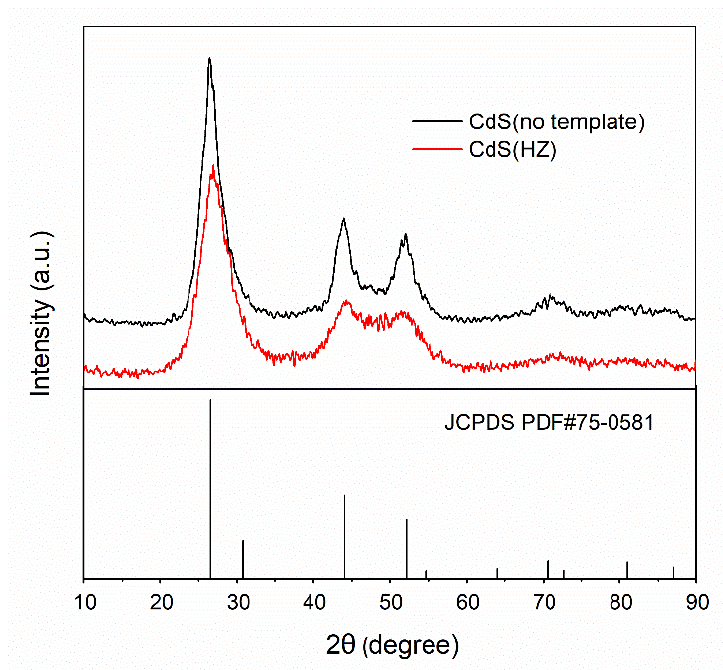
Figure 1. XRD patterns of CdS(HZ) and CdS prepared without template. The morphology and structure of the samples were further investigated by SEM and TEM. The SEM image of the hydrilla biotemplate (Figure S1) shows a sheet of plant leaf tissue on which the cellular structure of the leaf can be seen. The SEM image (Figure 2a) shows that the CdS(HZ) is composed of aggregations of tiny particles and no specific morphology could be observed. However, TEM images reveal the nano-aggregate networks of the sample. As shown in Figure 2b,c, the CdS nanoparticles in a diameter of about 3 to 5 nm aggregate, weave and intertwine into the network, presenting many gaps, pores, and cavities. The size of the crystals is in good agreement with the result from XRD. Lattice fringes corresponding to (111) crystal planes of cubic CdS can be also distinctly observed (Figure 2d). This fiber-like structure, which could be observed in a CdS aerogel [35], can often maximum volume and surface area with a given material mass. In contrast, CdS materials synthesized without biotemplates (CdS(no template)) are blocks composed of small particles, and no other morphological characteristics of interest were observed (Figure S2). Obviously, the difference of morphology between the two samples is caused by the use of biotemplate. However, the morphology of CdS(HZ) is not similar to that of the template. Therefore, unlike ZnIn 2 S 4 with a morphology similar to that of the biotemplate synthesized by using hydrilla in our previous work [21], the hydrilla template did not play the role of “hard template” when CdS was synthesized by using the method in